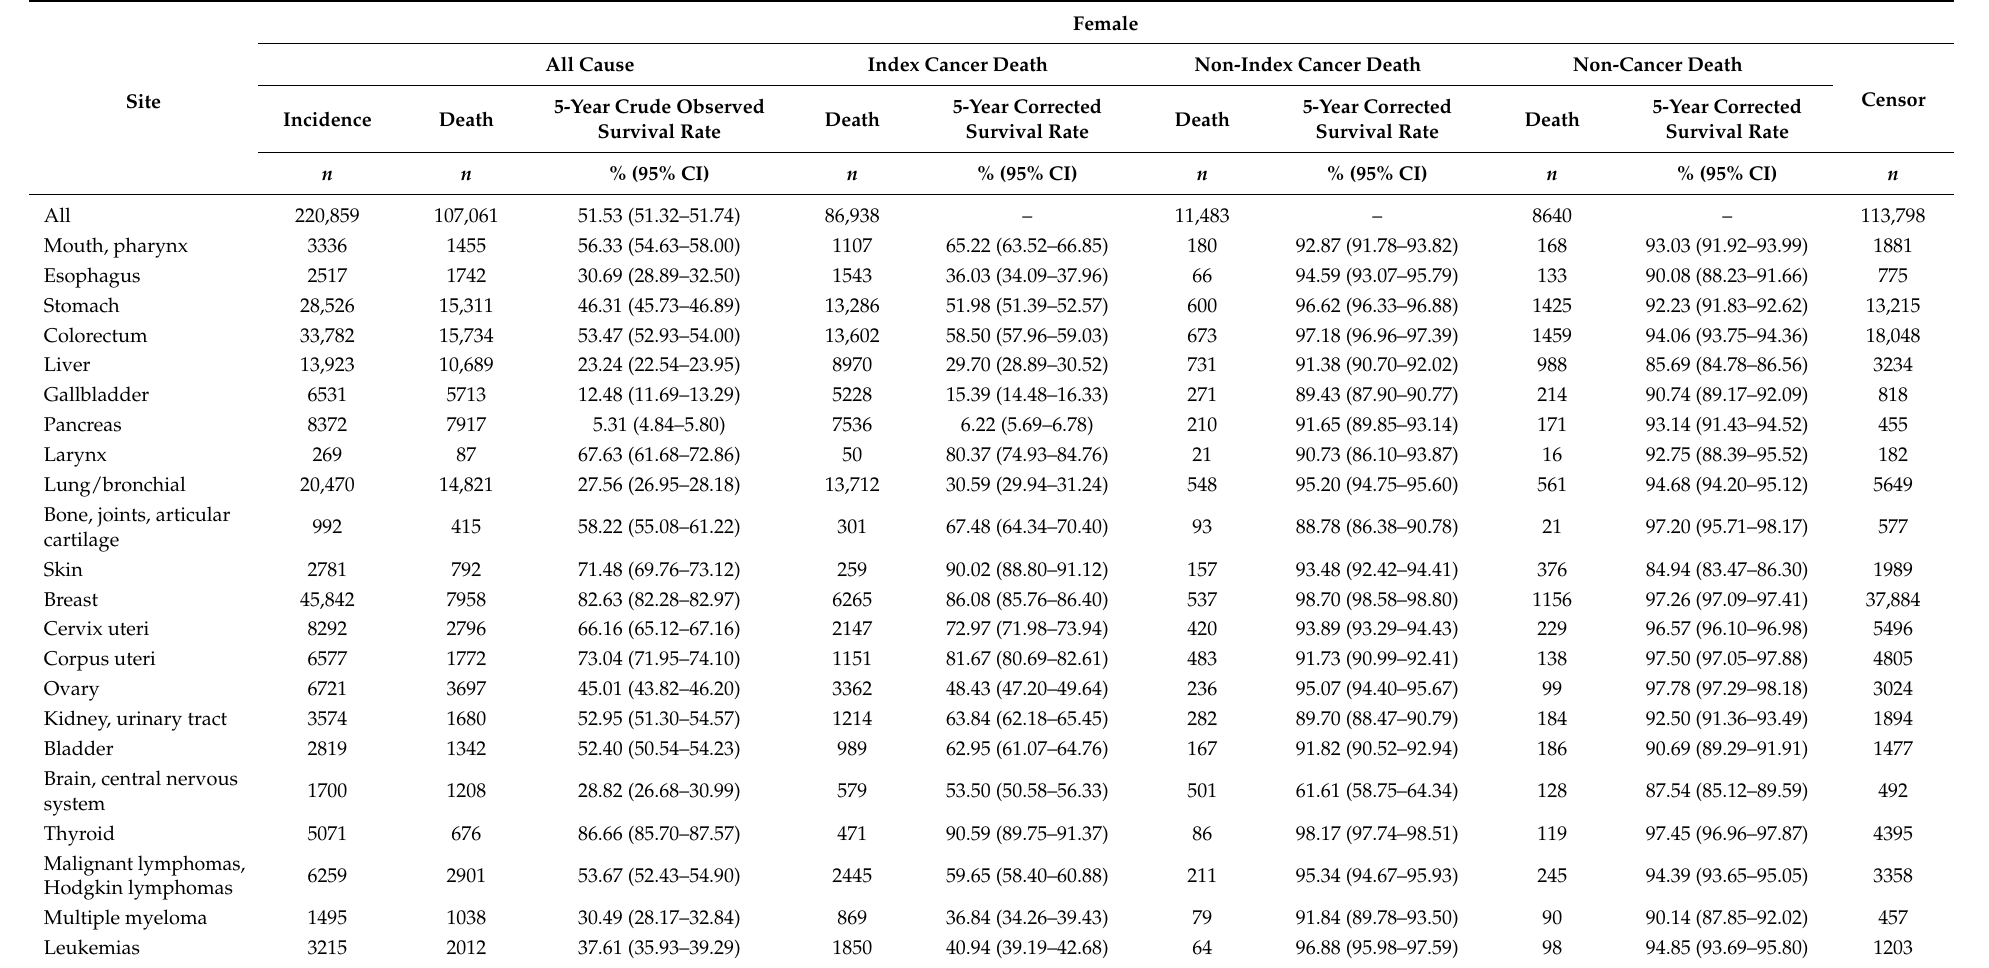
Table 5. Summary of cancer morbidity and 5-year cancer mortality by cause of death (female, incidence: 1995–2011, death or survival: